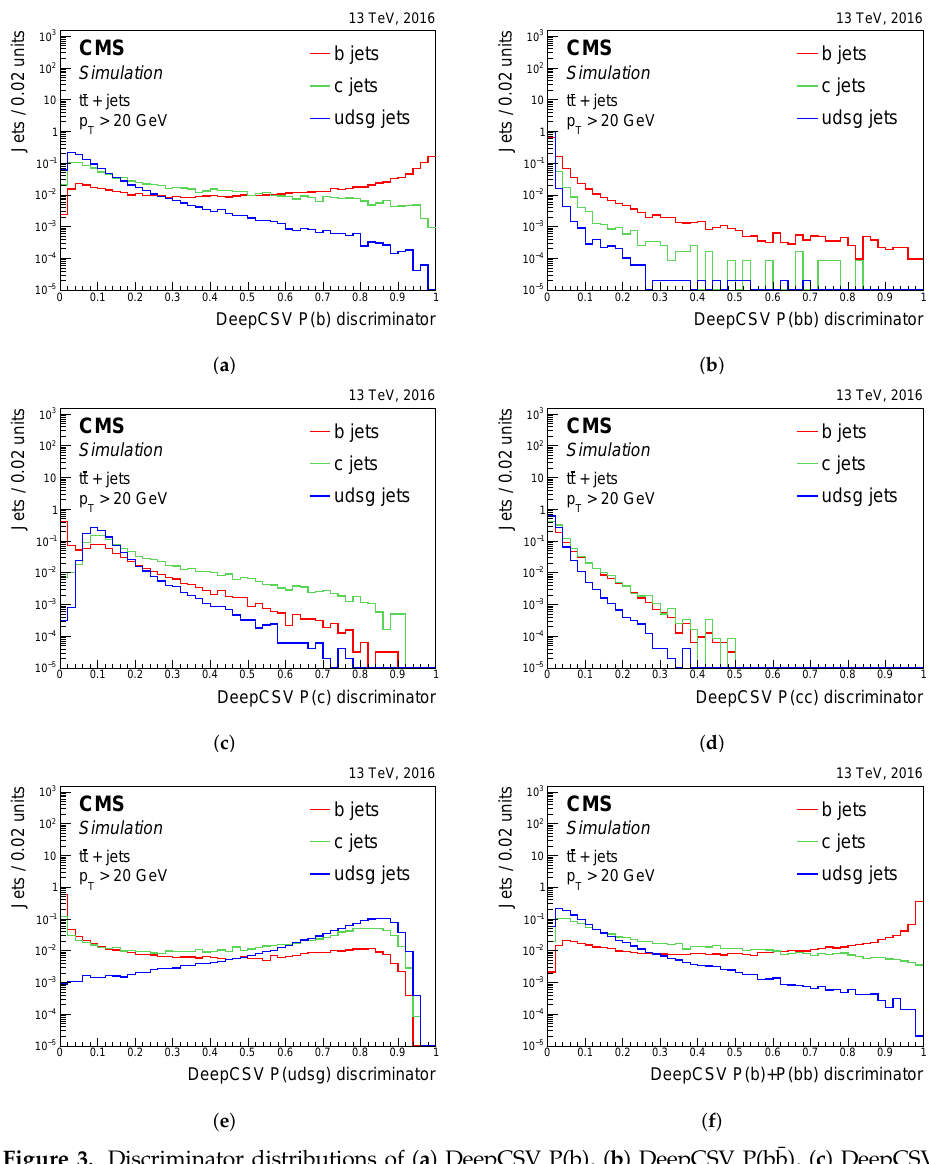
Figure 3. Discriminator distributions of ( a ) DeepCSV P(b), ( b ) DeepCSV P(b¯b), ( c ) DeepCSV P(c), ( d ) DeepCSV P(c¯c), ( e ) DeepCSV P(usdg), and ( f ) DeepCSV P(b)+P(b¯b) [18]. The DeepCSV tagger is used also for c tagging, which combines the